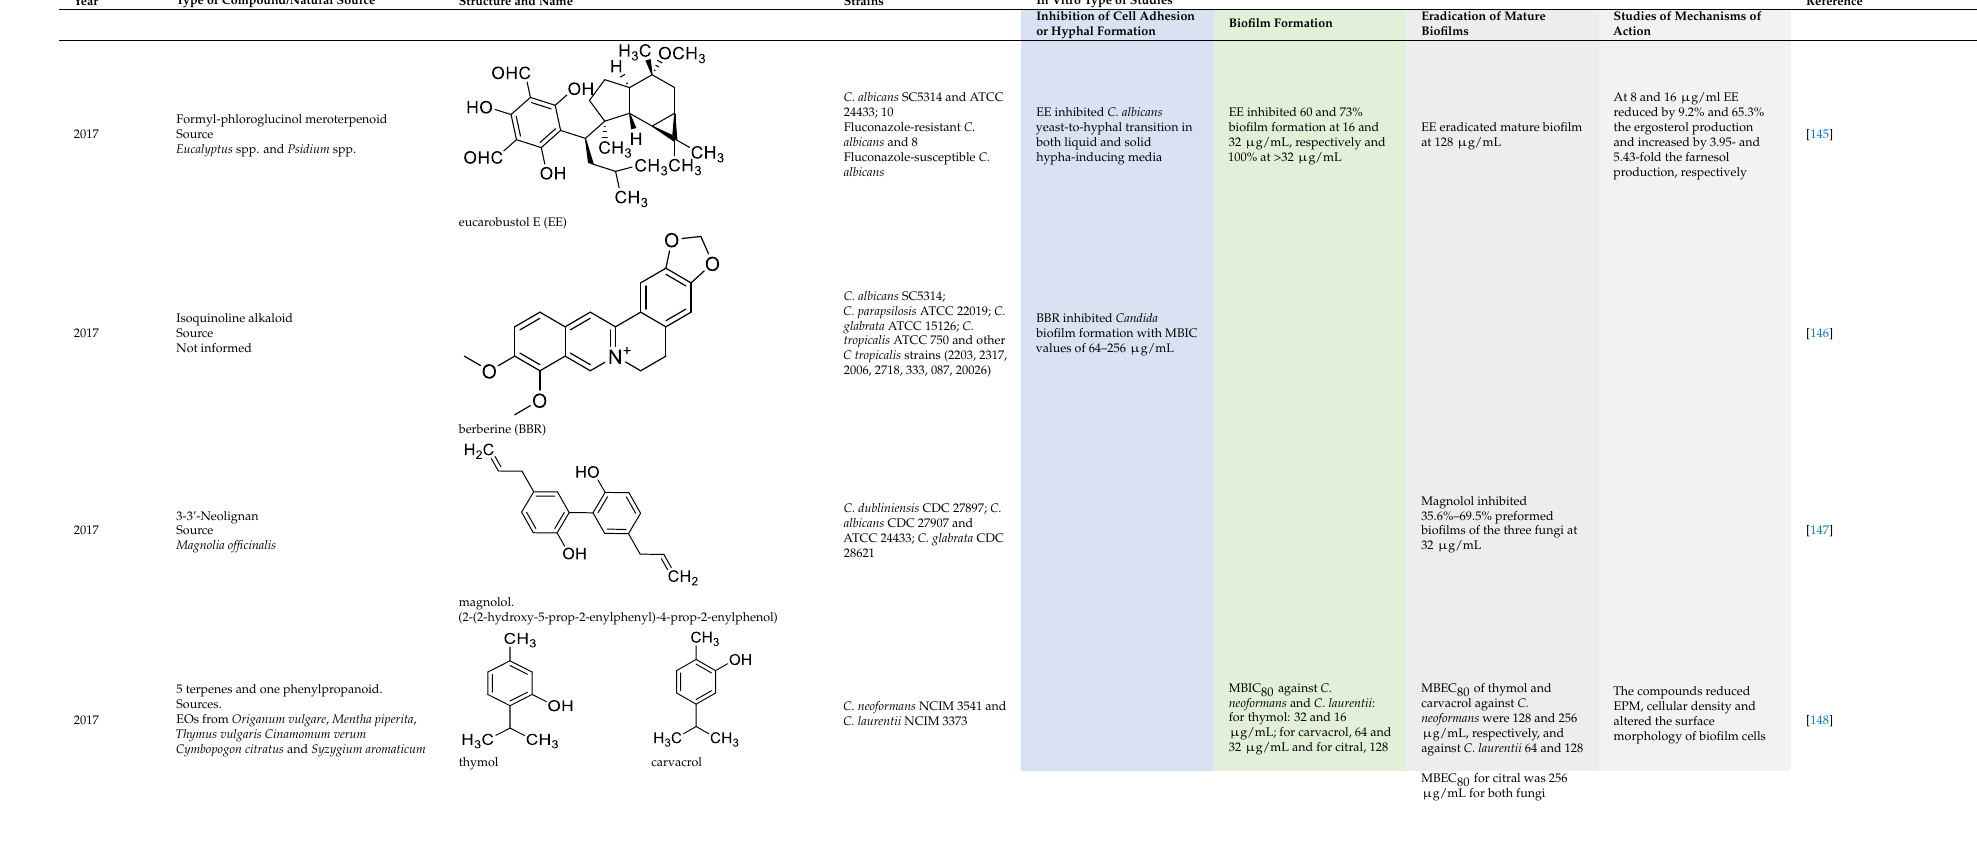
Table 4. More relevant results of natural compounds showing a capacity for inhibiting fungal biofilms.